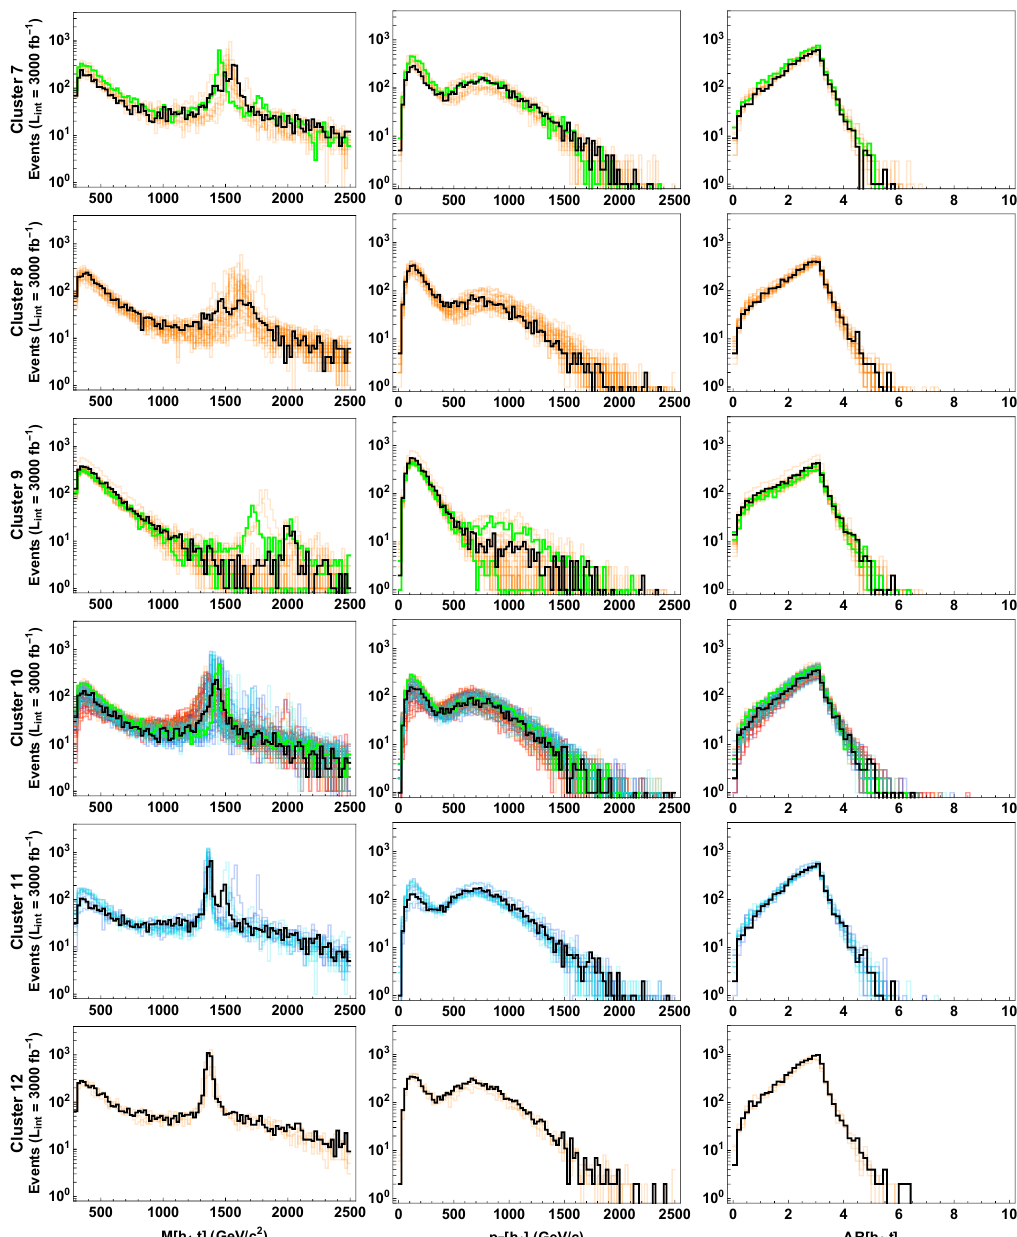
√ Figure 23 . Distributions at s = 14 TeV for the invariant mass of the pair composed by top and most energetic Higgs h 1 (first column), transverse momenta of h 1 (second column) and angular distances in the transverse plane between h 1 and the top (third column), organized in clusters by similarity (clusters 7 through 12). Red, blue, orange and cyan curves indicate respectively points in Regions I, II, III and IV of the MCHM 14 . The benchmark point for each cluster is shown in black, with clusters 7 to 12 containing respectively points D 7 to D 12 in table 6 of the main article. The example points (table 2 is the main article) are shown in green (cluster 7 contains Q 2 , cluster 9 contains Q 3 and Q 4 and cluster 10 contains Q 6